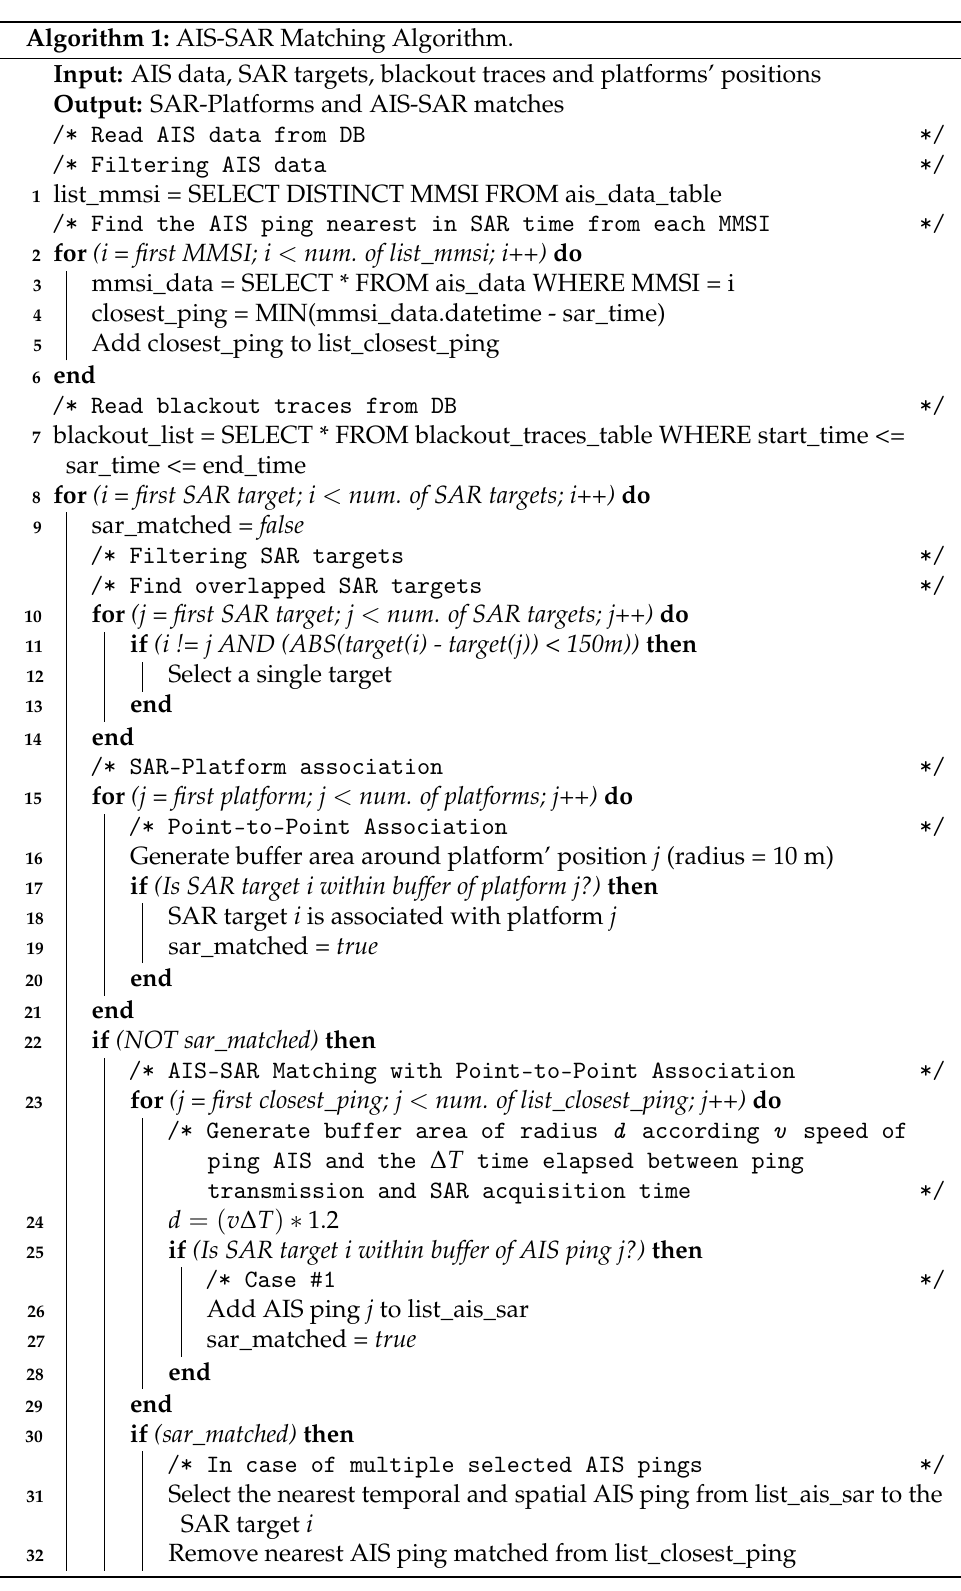
Algorithm 1: AIS-SAR Matching